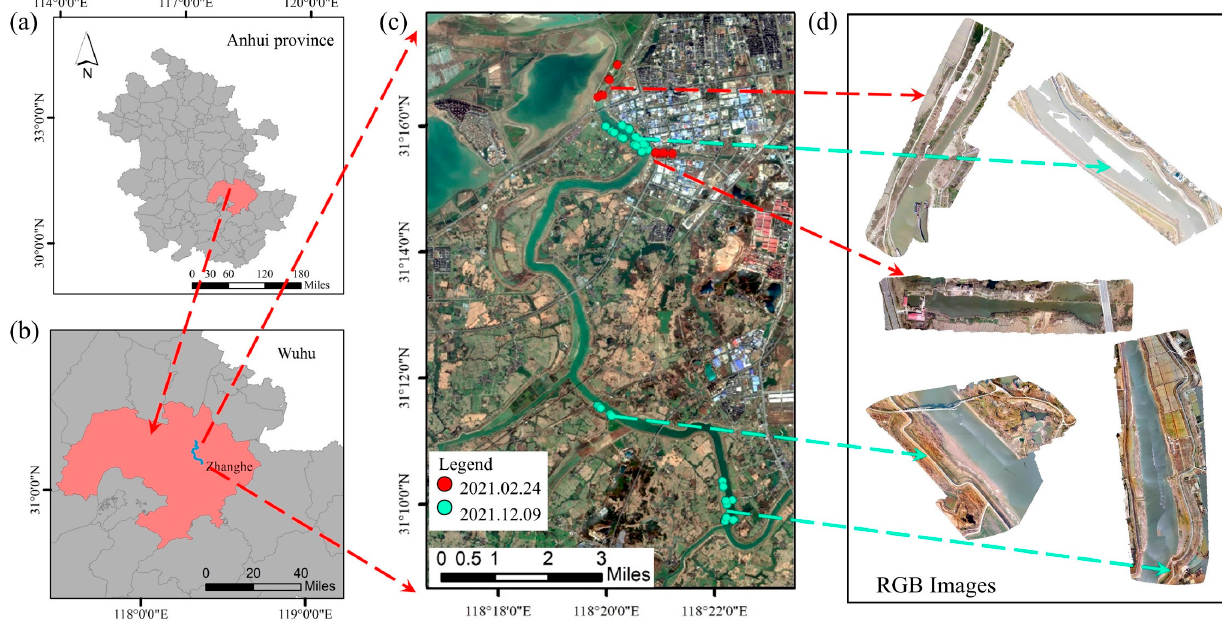
Figure 1. Geographic location of the study area and the distribution of the selected sampling points: ( a ) location of Anhui Province, ( b ) location of the city of Wuhu, ( c ) location of water sampling points on the Zhanghe River, and ( d ) examples of UAV-derived RGB orthophotography of the research river sections.